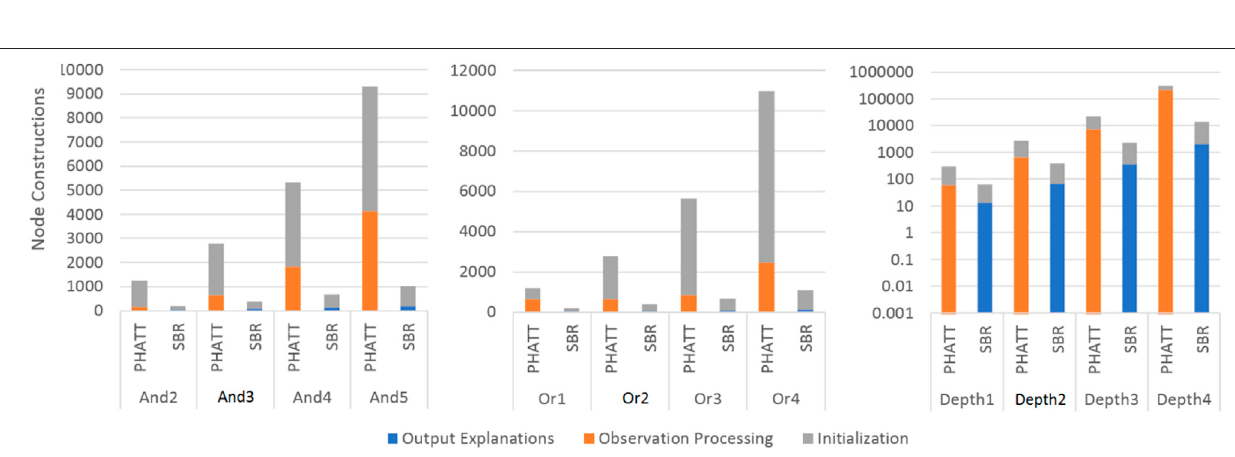
FIGURE 11 | A comparison of space usage by SBR with HSQ and PHATT. In the Depth graph, the y axis is in log scale.